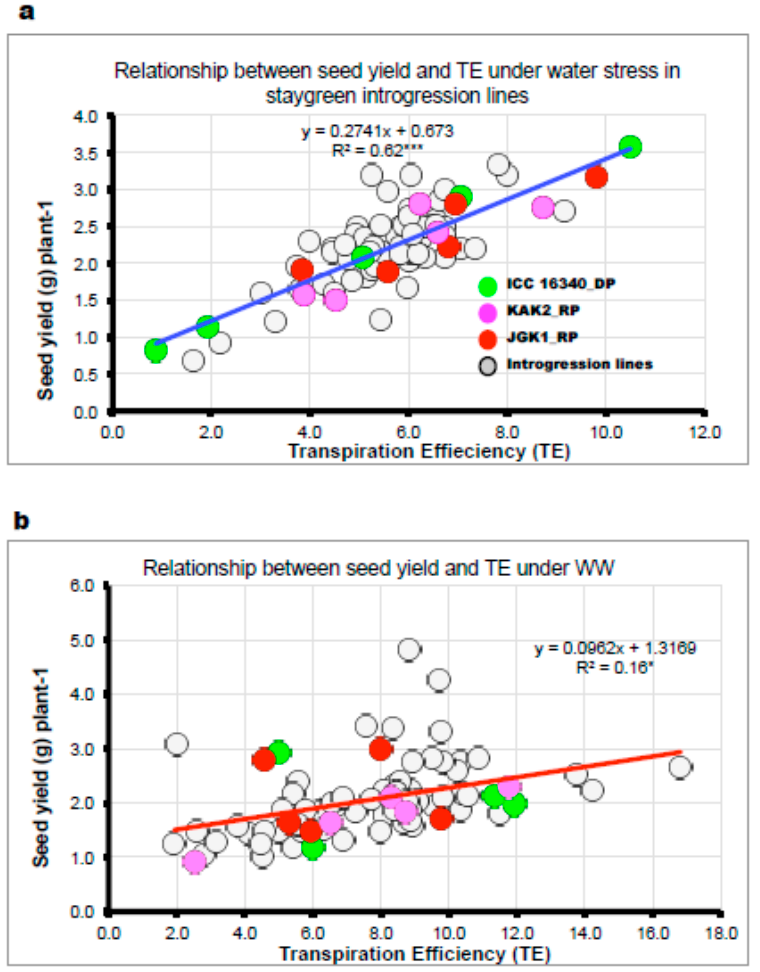
Figure 6. Relationships between seed yield and transpiration e ffi ciency (TE) under ( a ) water stressed (WS) and ( b ) well watered conditions (WW) in stay green chickpea genotypes grown in the PVC cylinders (Lysimetric facility). The data used for these regression analyses are replicated data, obtained under WS and WW conditions. For each genotype, five replicates data points were used to draw the linear regressions. The stay green donor parent (ICC 16340) data are represented in green colour, recurrent parent (JGK1) data are represented in red colour, recurrent parent (KAK2) data are represented in pink colour and introgression lines (ILs) are represented in grey colour. The slopes and R 2 of regressions are displayed in the figures. R 2 values with * and *** (astric) symbols are significantly di ff erent at p < 0.05 and p < 0.001.